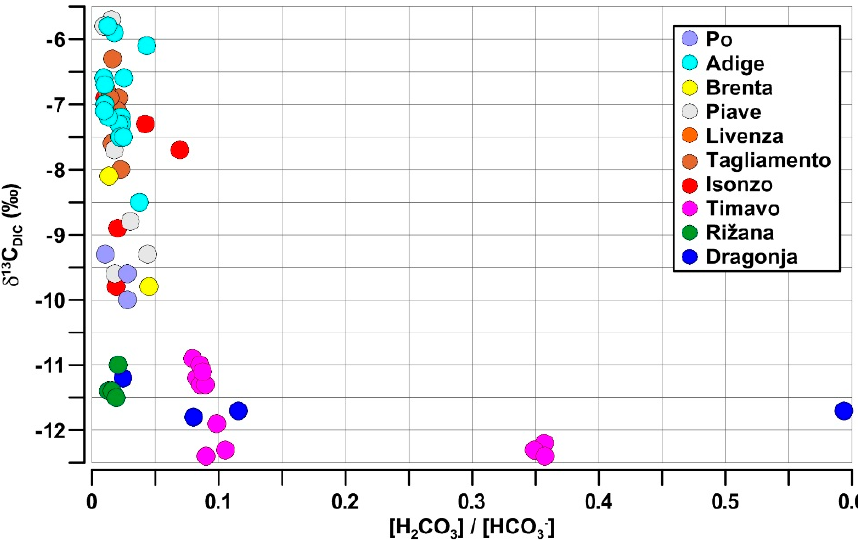
Figure 6. δ 13 C DIC values (‰) in the NAd rivers as a function of the [H 2 CO 3 ]/[HCO 3 − ] ratio in fresh- water.